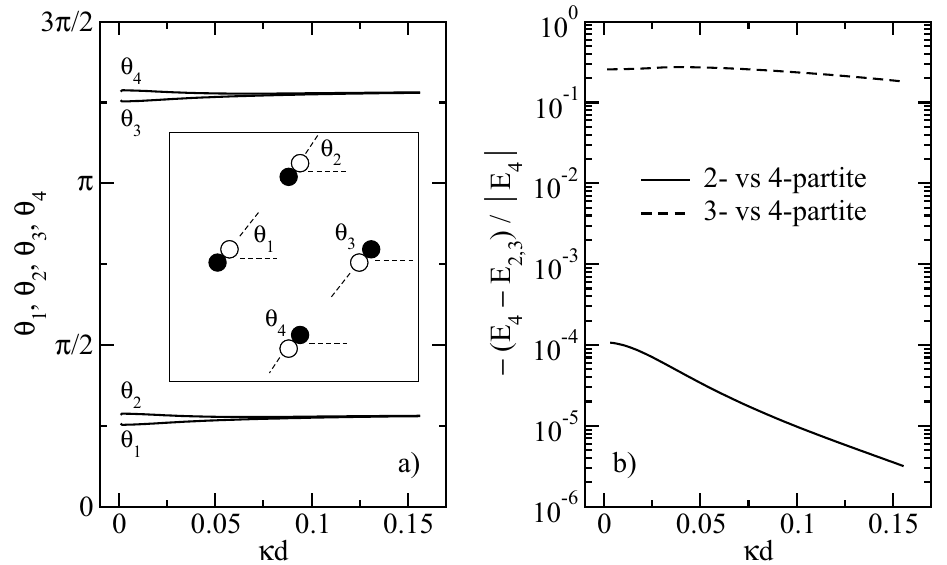
Fig. 8 – Emergence of tetrapartite ground state configurations for opposite charged dimers on a triangular lattice with α = 0 . 7 and κ l = 0 . 8: (a) the parameter dependence of tetrapartite angles and (b) a comparison of ground state energies E i calculated for bipartite ( E 2 ), tripartite ( E 3 ) and tetrapartite ( E 4 ) lattices. In the inset of (a) we show the tetrapartite unit cell configuration for κ d = 0 .